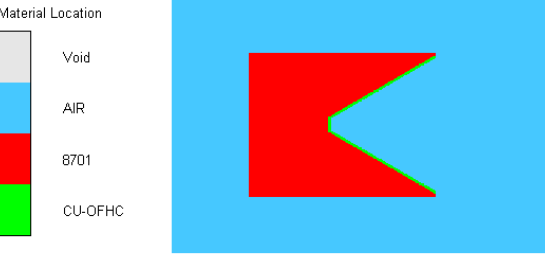
Figure 6. SC finite element model.